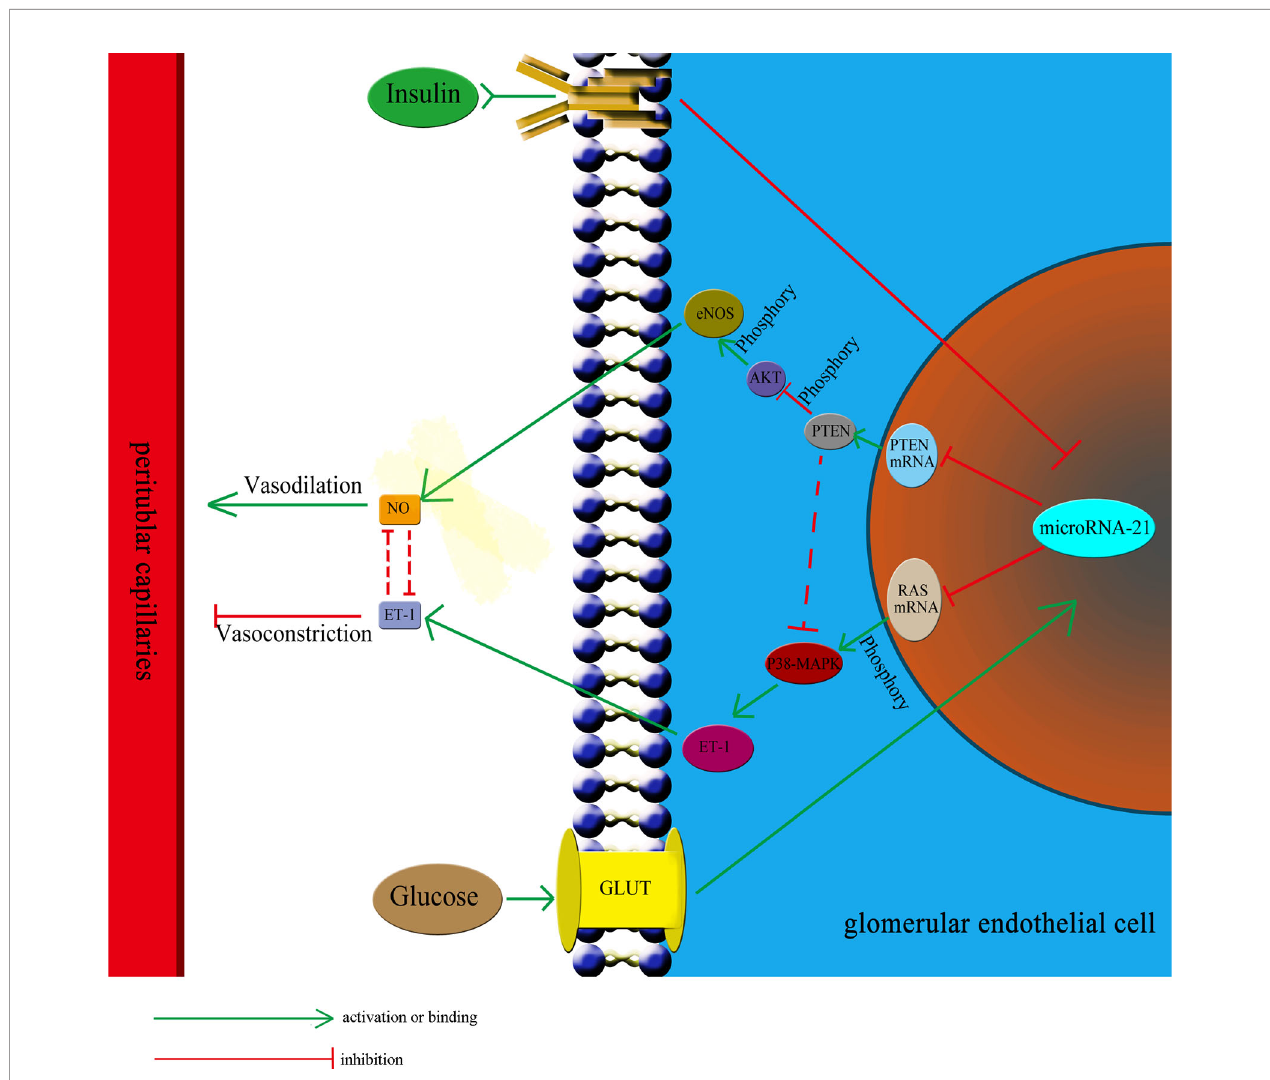
FIGURE 7 | The relative balance of of insulin and glucose regulates the function of HGECs and peritubular capillaries. The relative balance of insulin and glucose regulates the balance of the PTEN/AKT/eNOS and P38-MAPK/ET-1 pathways protein expression by affecting the expression of miR-21, which in turn affects the balance between the secretion of ET-1 and NO and regulate the blood fl ow through peritubular capillaries. The unbalance of insulin and glucose would have cascading effect on the expression of downstream proteins and lead to unbalanced secretion of ET-1 and NO, resulting in ischemia and hypoxia in renal tubules. GLUT, glucose